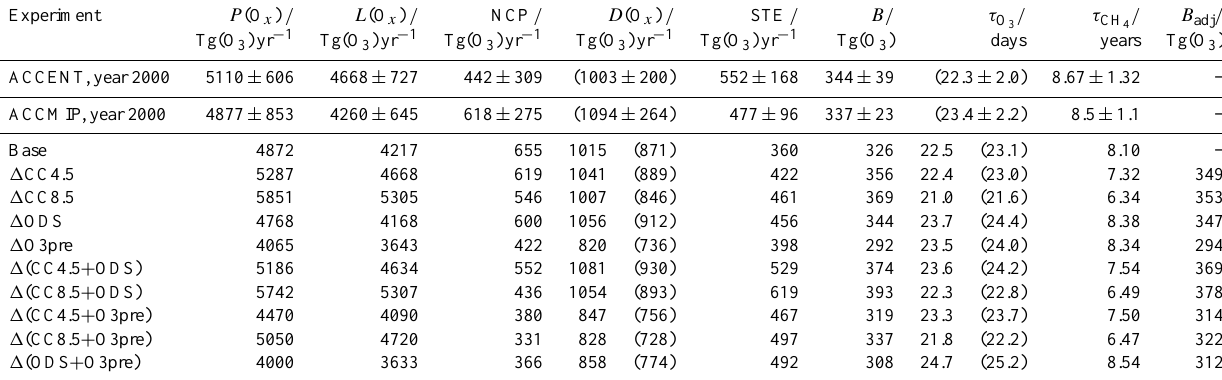
Table 2. Tropospheric O x budget for the experiments detailed in Table 1. The definition of O x employed here is given in the Introduction. Also reported is the tropospheric lifetime of ozone ( τ O ) and whole atmosphere lifetime of methane ( τ CH ). The latter includes loss by 3 4 tropospheric OH (diagnosed by the model), a soil sink (lifetime 160 years) and a stratospheric sink (lifetime 120 years). The final column shows values of the ozone burden after adjusting to account for methane feedbacks ( B adj ) (see Sect. 4.3 for details). Two sets of multi-model means for the year 2000 are included for comparison with the Base run: ACCENT values (first row) are taken from or calculated from data in , which has been calculated from the Stevenson et al. (2006), and ACCMIP (second row) from Young et al. (2013) for all terms except τ CH 4 tropospheric methane lifetimes reported in Naik et al. (2013). Note that, in this study, the D (O x ) term totals dry deposition of ozone (listed in brackets) plus deposition of those reactive nitrogen compounds that are classed as O x , whereas the ACCENT and ACCMIP studies only report the former. The same applies in the calculation of τ O 3